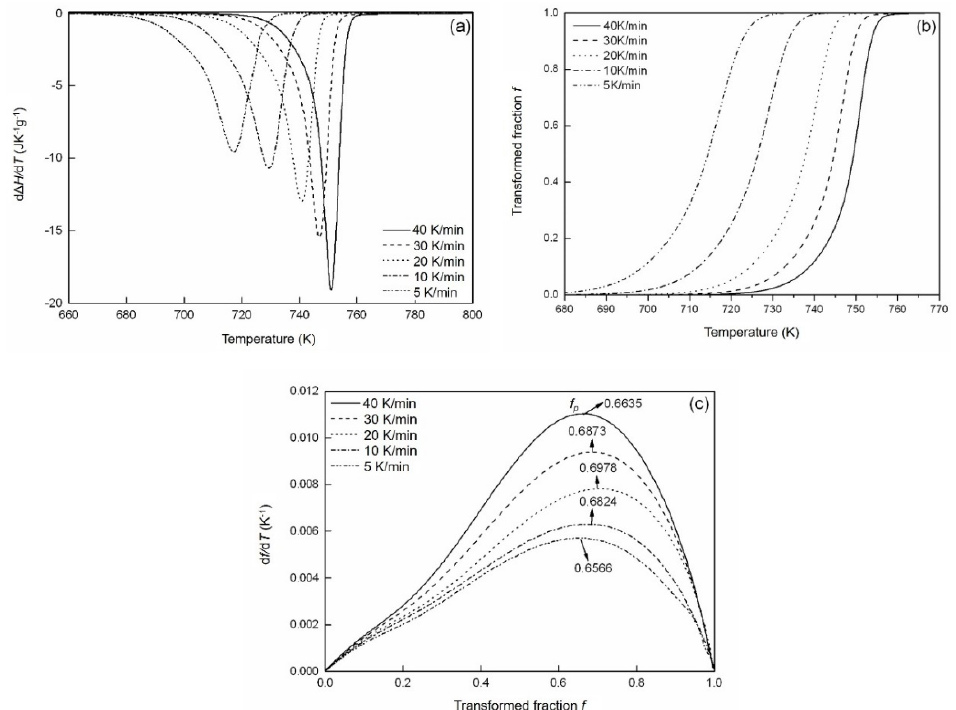
Figure 4. ( a ) Rate of enthalpy change divided by the heating rate d ∆ H / Φ dt = d ∆ H / dT , ( b ) evolution of transformed fraction f with temperature T and ( c ) evolution of df / dT (transformation rate) with transformed fraction f , derived from differential scanning calorimetry (DSC) measurement of the amorphous Fe 85 B 15 alloy after being isochronally crystallized, with heating rates Φ of 5, 10, 20, 30 and 40 K min − 1 . The values of f p are larger than 1 − 1/e (c). The fitting was carried out by applying a downhill simplex method [45]. With adjust- ing the kinetic parameters K 0 , n and ε , the least-squares difference is obtained between the calculated values using the model and the experimentally measured curves. The quality of the fitting is given by the ratio between the total of the absolute differences (i.e., fitted df / dt values subtracted from the measured df / dt values) and the sum of all the fitted df / dt absolute values. The fitting results are reproduced in Figure 5. The kinetic parameters K 0 , n and ε determined by this analysis are summarized in Table 1. The overall activation energy Q at each heating rate can then be calculated from the values of nQ ; the activation